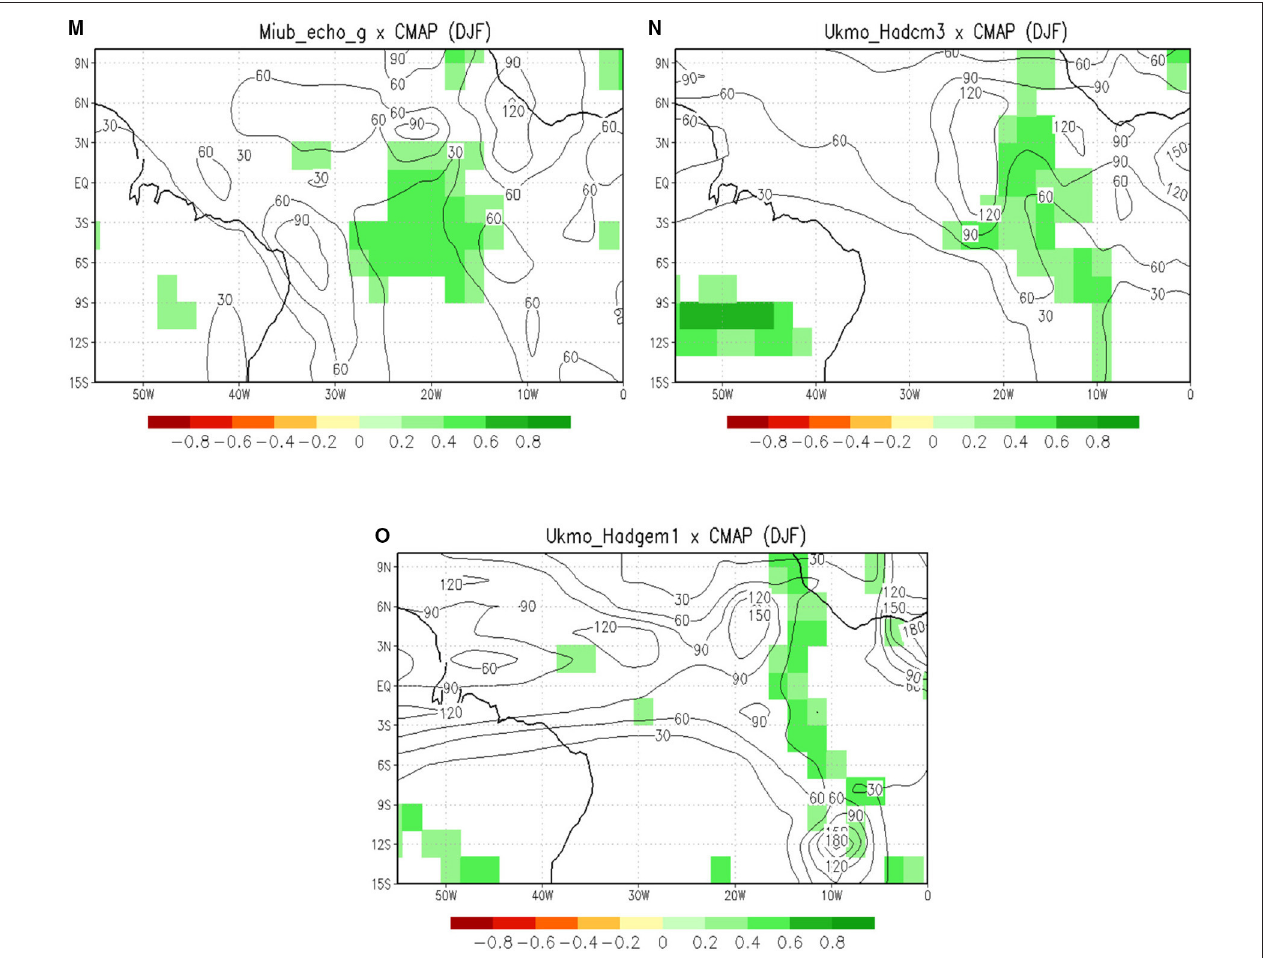
FIGURE 5 | Correlation (shaded) and absolute error (contour in mm) to summer (DJF) between observation (CMAP) and simulation from CMIP3-AR4 models for period 1979–2000. The models considered are (A) Bccr_bcm2_0, (B) Ccma_cgcm3_1_T63, (C) Cnrm_cm3, (D) BNu_Esm, (E) Gfdl_cm2_0, (F) Gfdl_cm2_1, (G) Giss_m_e_r, (H) Iap_goals_1_0, (I) Ingv_ECHAM4, (J) Inmcm3_0, (K) Ipsl_cm4, (L) Miroc3_2_medres, (M) Miub_echo_g, (N) Ukmo_Hadcm3, and (O) Ukmo_Hadgem1. Green areas indicate statistical significance of the correlation at 95% according to the Student’s t